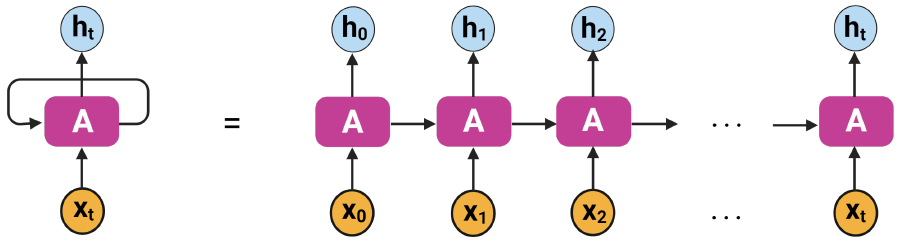
Figure 2. An unrolling RNN architecture